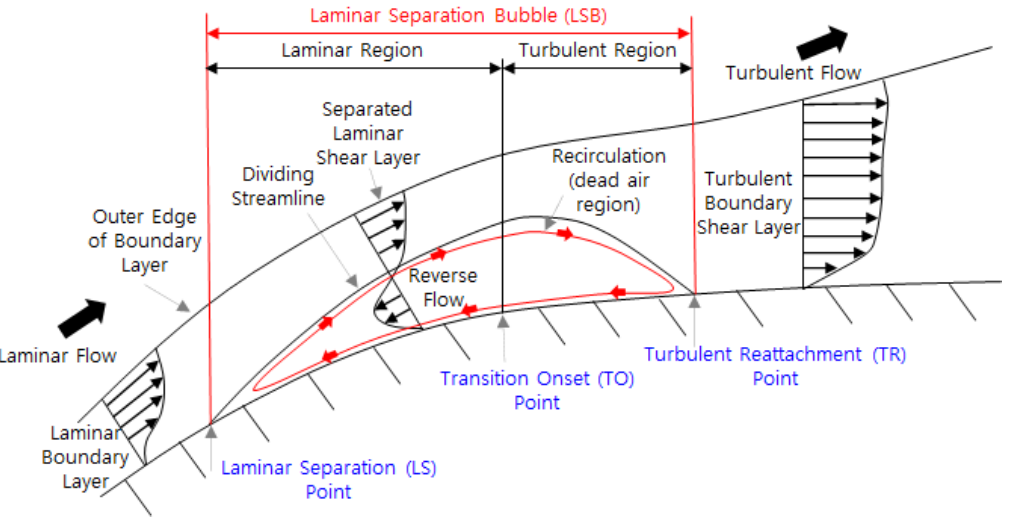
Figure 1. General characteristics of a laminar separation bubble (LSB) and separation-induced transition, reproduced from Horton (1968).